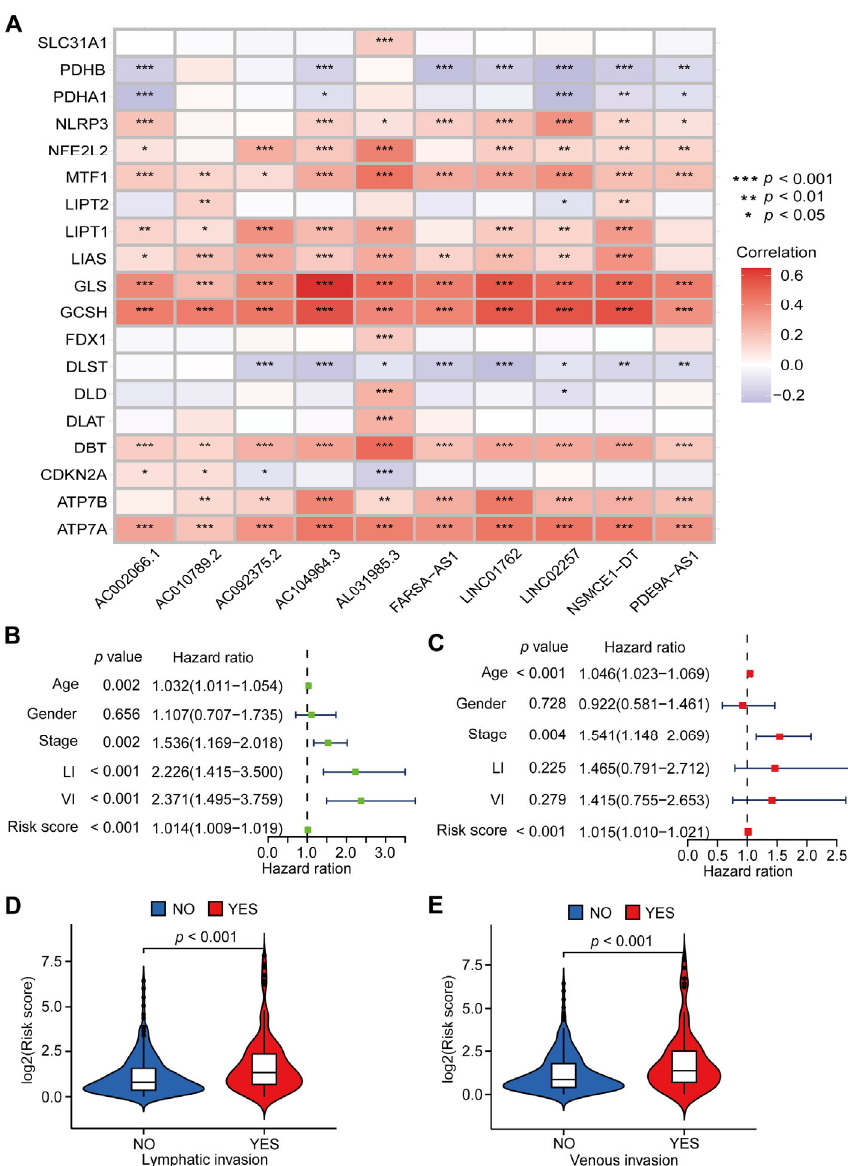
Figure 4. Cox analysis for prognostic characteristics of CRLs. ( A ) The correlation heatmap between 10 prognostic CRLs and 19 cuproptosis ‐ related genes (* p < 0.05, ** p < 0.01, and *** p < 0.001). ( B , C ) Univariate Cox regression analysis ( B ) and multivariate Cox regression analysis ( C ) for the CRLs ‐ risk score and clinical characteristics in CC patients (LI means lymphatic invasion and VI means venous invasion). ( D ) Risk score of patients with or without LI (“NO” group means patients without LI and “YES” group means patients with LI, p < 0.001). ( E ) Risk score of patients with or without venous invasion (“NO” group means patients without VI and “YES” group means patients with VI, p < 0.001).